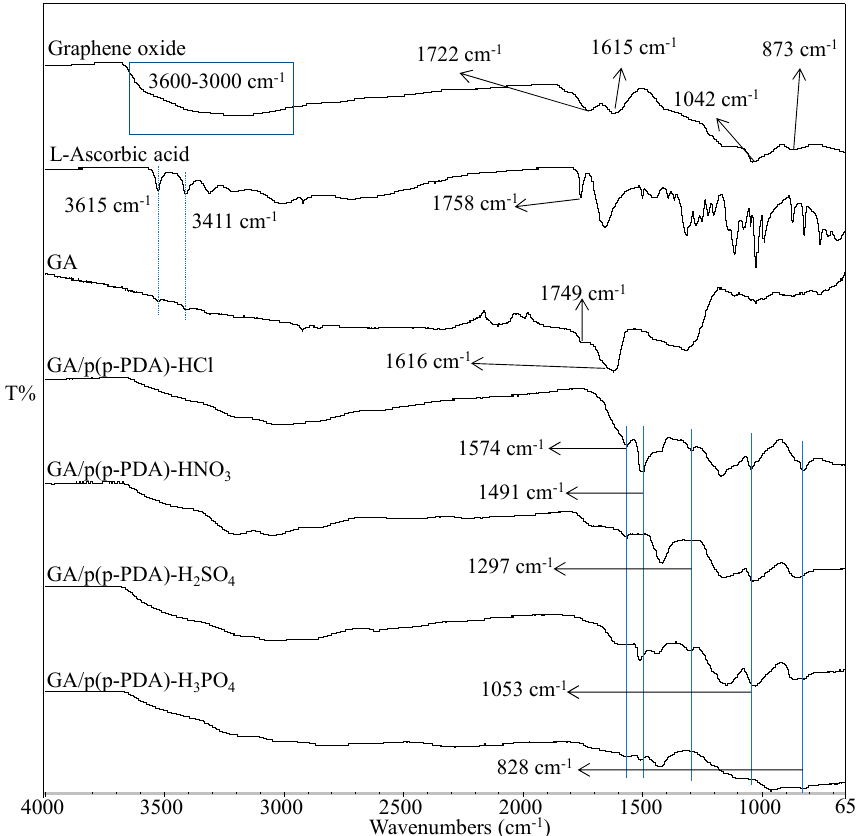
Figure 3. FT-IR spectra of GA / p(p-PDA) composites doped with various types of acids.